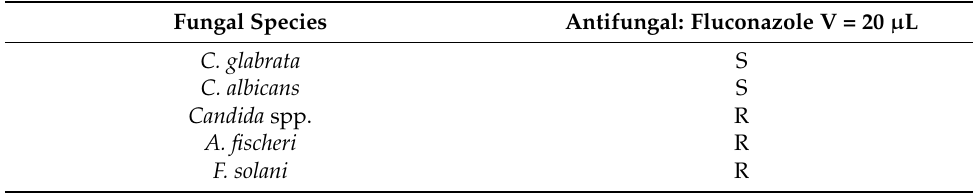
Table 8. Susceptibility test of fungal strains to